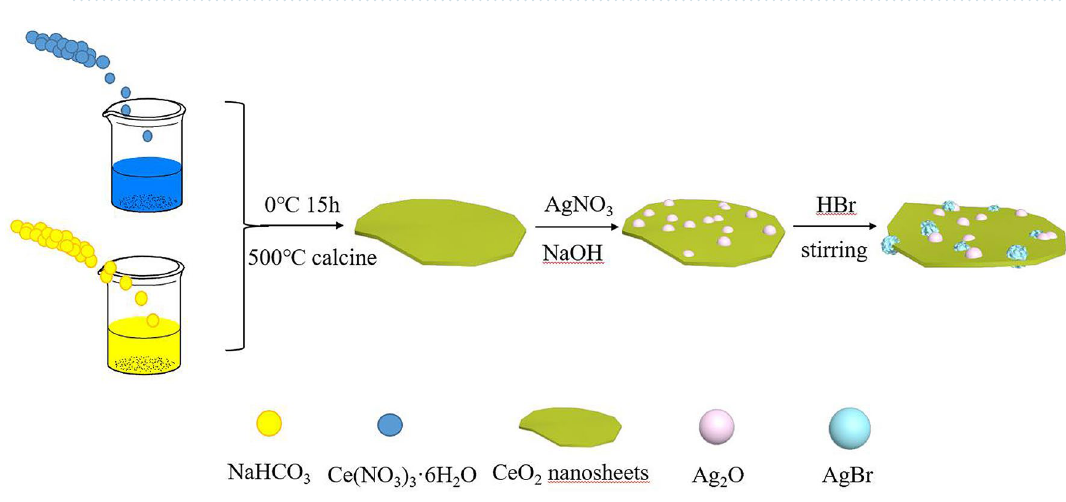
Scheme 2. Schematic diagram of Ag 2 O/AgBr–CeO 2 catalyst preparation